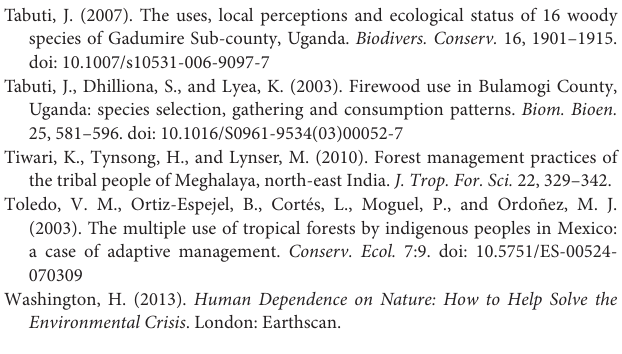
Tabuti, J. (2007). The uses, local perceptions and ecological status of 16 woody species of Gadumire Sub-county, Uganda. Biodivers. Conserv. 16, 1901–1915. doi: 10.1007/s10531-006-9097-7 Tabuti, J., Dhilliona, S., and Lyea, K. (2003). Firewood use in Bulamogi County, Uganda: species selection, gathering and consumption patterns. Biom. Bioen. 25, 581–596. doi: